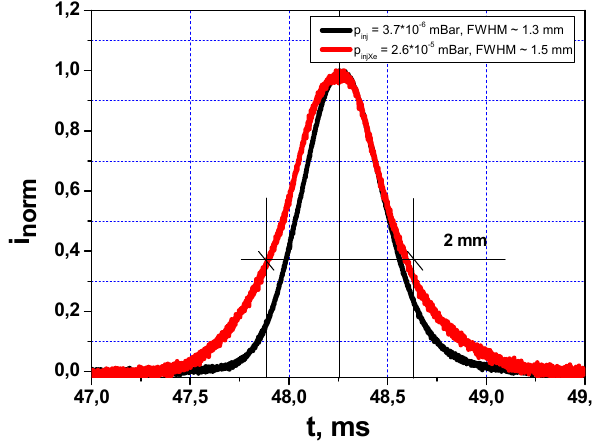
Figure 12. Normalized profiles of Xe + primary ions across wire monitor.